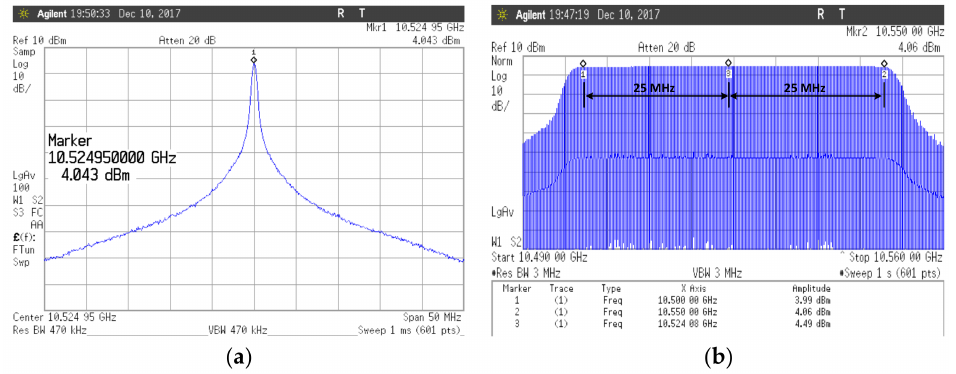
Figure 23. The output spectrum of ( a ) the Doppler mode in which the output frequency is fixed and ( b ) the FMCW mode with the 50 MHz modulated